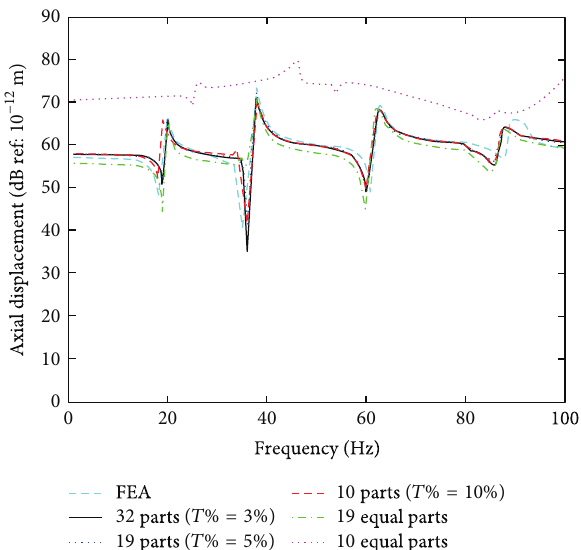
Figure 8: Validity and convergence of solving far-field